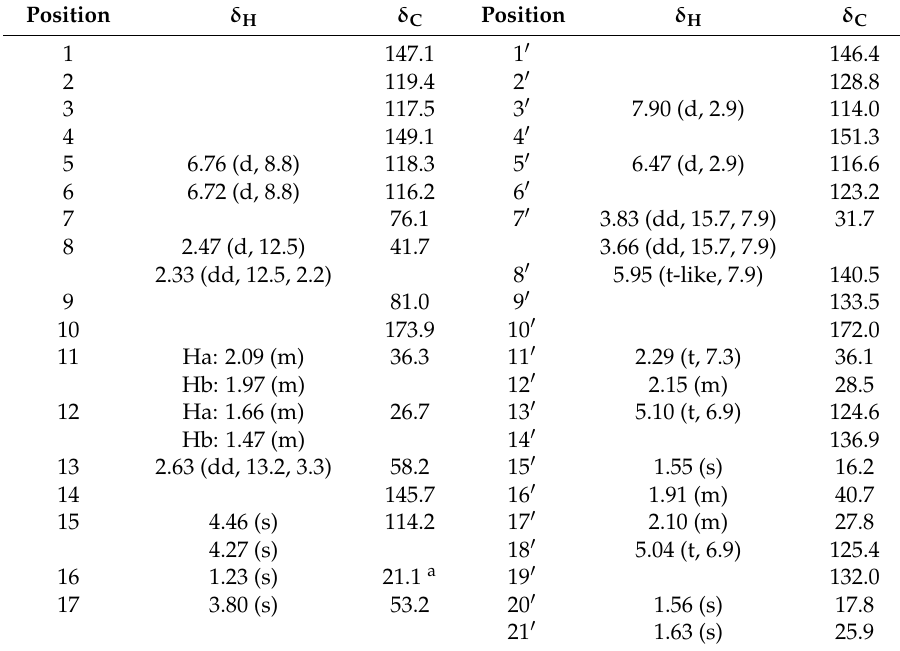
Table 3. 1 H- (600 MHz) and 13 C-NMR (150 MHz) data of 3 in methanol- d 4 ( δ in ppm, J in